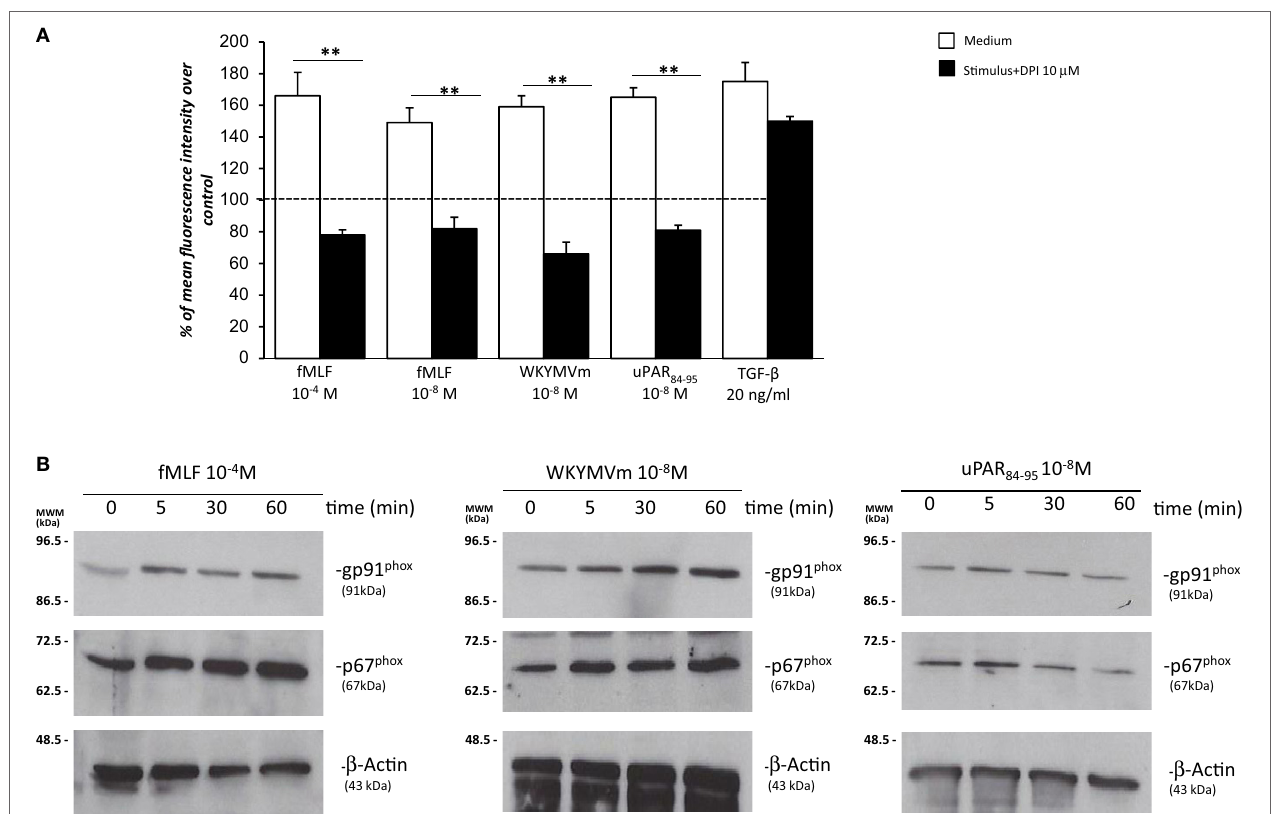
FigUre 5 | Effects of the NOX-inhibitor diphenyleneiodonium (DPI) on N -formyl peptide receptor (FPR)-mediated reactive oxygen species (ROS) production and FPRs-induced modulation of gp91 phox and p67 phox expression in BJ cells. (a) BJ cells were plated in a 96-well plate and pretreated for 1 h at 37°C with 10 µM of the NOX-inhibitor DPI. At the end of incubation, cells were treated with N -formyl- l -methionyl- l -leucyl- l -phenylalanine (fMLF), WKYMVm peptide, uPAR 84–95 peptide, or TGF- β . Results are expressed as percentage of increase of mean fluorescence intensity of stimulated DCHF-DA-loaded cells in respect to unstimulated DCHF-DA- loaded cells (considered as 100%). Values are the mean ± SEM of three experiments performed in triplicate. ** p < 0.001. (B) Western blot analysis with anti -